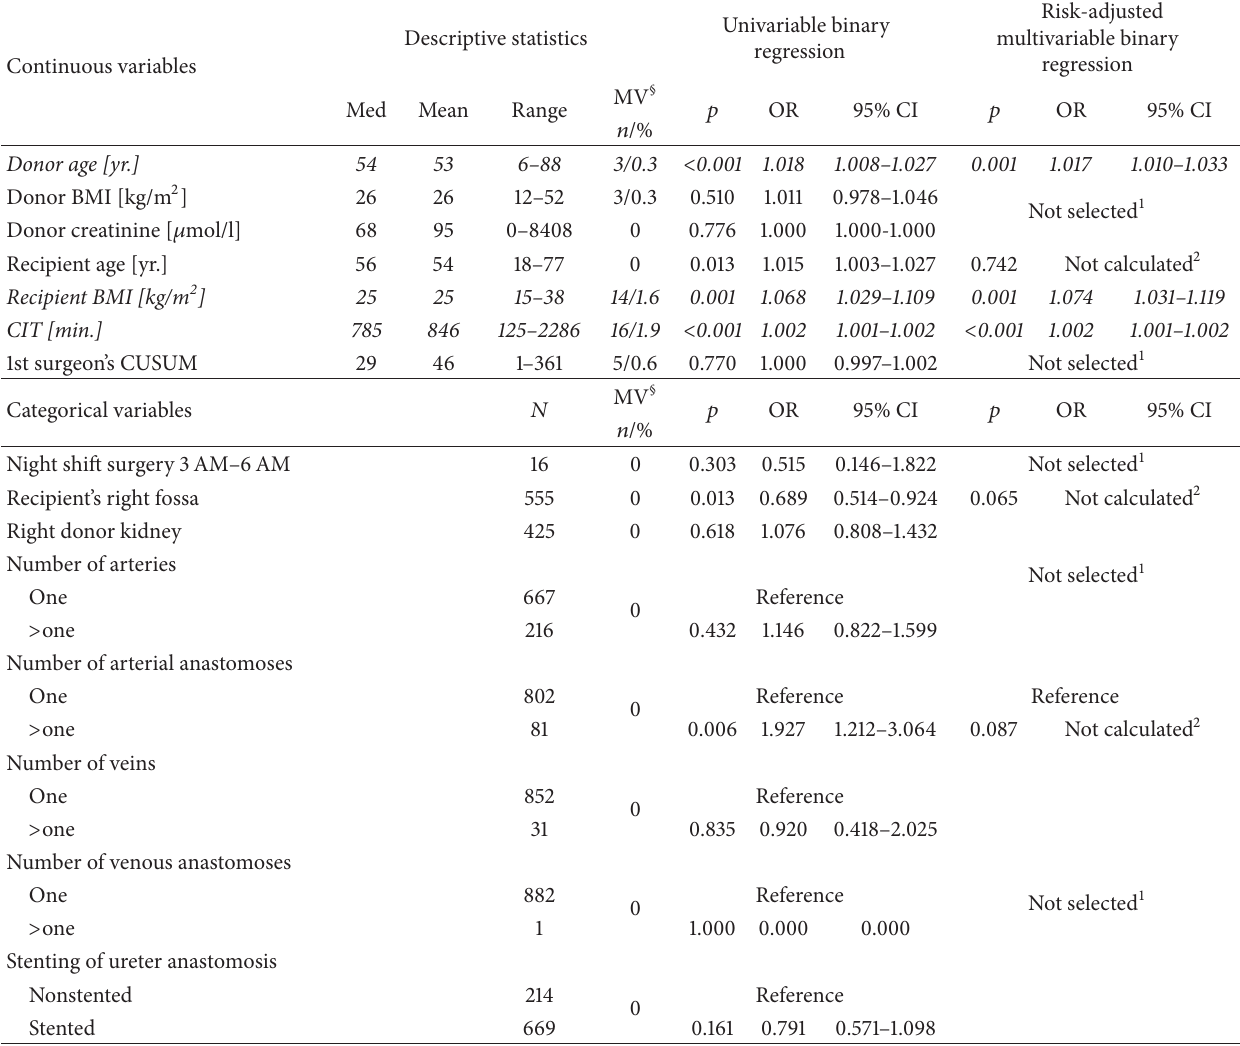
Table 6: Regression analysis of the risks for delayed graft function ( 𝑛 = 272 ). Shown are the results of univariable and multivariable binary regression analyses to determine the odds ratios of the investigated variables for the risk of delayed graft function ( 𝑛 = 272 ). Dialysis data were retrospectively available for 985 cases. Patients with perioperative graft nephrectomy and with discharge on dialysis were censored ( 𝑛 = 102 ). Analyzed were all remaining cases ( 𝑛 = 883 ). Included into risk-adjusted multivariable analyses were only transplant variables with a 𝑝 value ≤ 0.2 in univariable regression